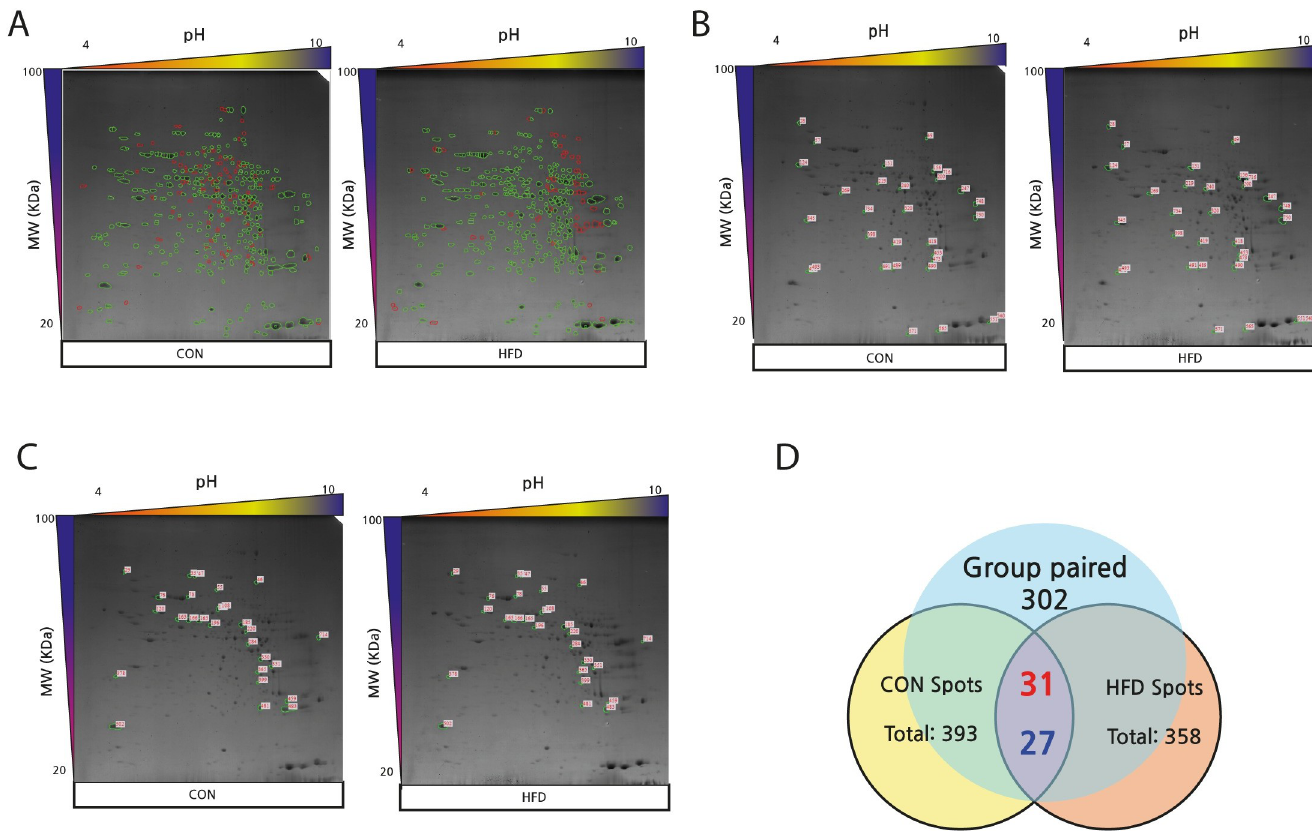
Fig 2. 2D-PAGE images and Venn diagram showing differential protein expression ( > 2-fold) between CON and HFD groups (A-D). (A) The images of 2D-PAGE show green circles indicating group paired spots, and red circles indicating group non-paired spots. Green circles indicate group paired spots, and orange circles indicate group non-paired spots. The images of the 2D-PAGE show an increase of 31 spots (B) and a decrease of 27 spots (C) among the 302 paired spots in HFD compared to CON. The differentially expressed spots showed a difference of > 2.0-fold. (D) The numbers in red denote upregulated spots and the numbers in blue indicate downregulated spots, in the Venn